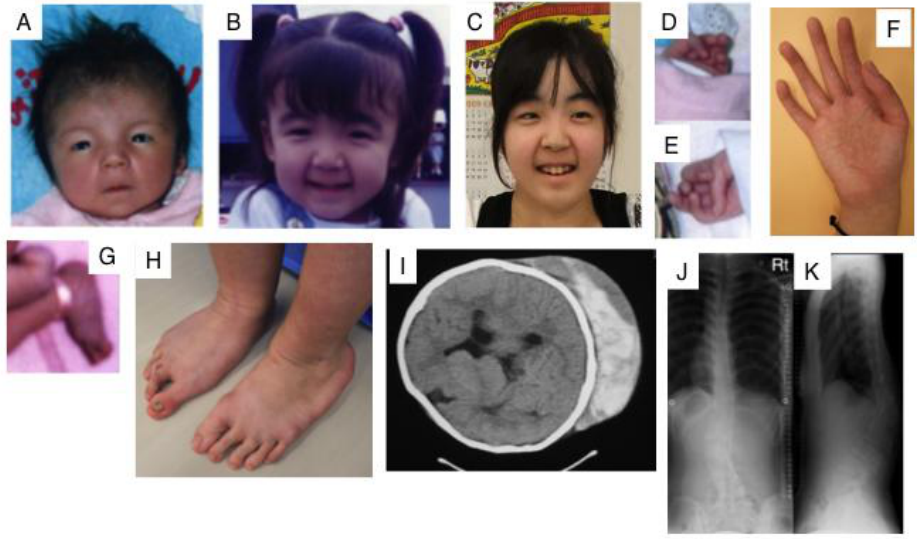
Figure 3. Clinical photographs of a patient with EDS caused by a carbohydrate sulfotransferase 14/dermatan 4- O -sulfotransferase-1 (CHST14/D4ST1) deficiency. Craniofacial features at the age of 23 days ( A ); three years ( B ); and 16 years ( C ) indicate hypertelorism; short and downslanting palpebral fissures, blue sclerae, a short nose with a hypoplastic columella, long philtrum, thin upper lip vermilion, small mouth, and micro-retrognathia at birth to early childhood. A slender and asymmetrical facial shape with a protruding jaw from adolescence is also observed. Congenital contracture of the fingers include adducted thumbs at 23 days ( D , E ); slender and cylindrical fingers and wrinkling palmar creases at 16 years ( F ); talipes equinovarus at birth ( G ); progressive foot deformities with talipes planus and valgus at 16 years ( H ); large subcutaneous hemtomas in a patient